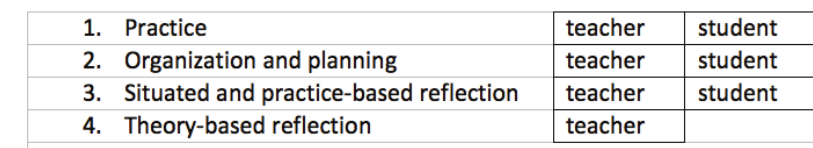
Figure 2: Four levels of the Design for Learning